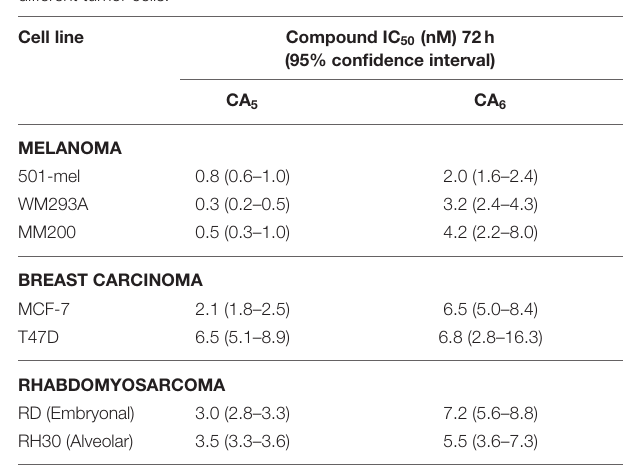
TABLE 1 | Cytotoxic activity of chromomycins A 5 (CA 5 ) and A 6 (CA 6 ) against different tumor cells.